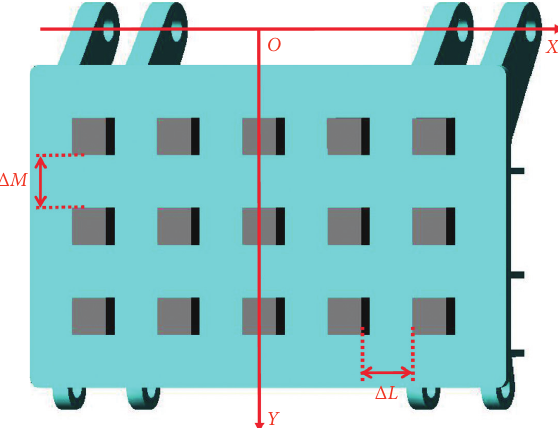
Figure 13: Schematic of the cushion block